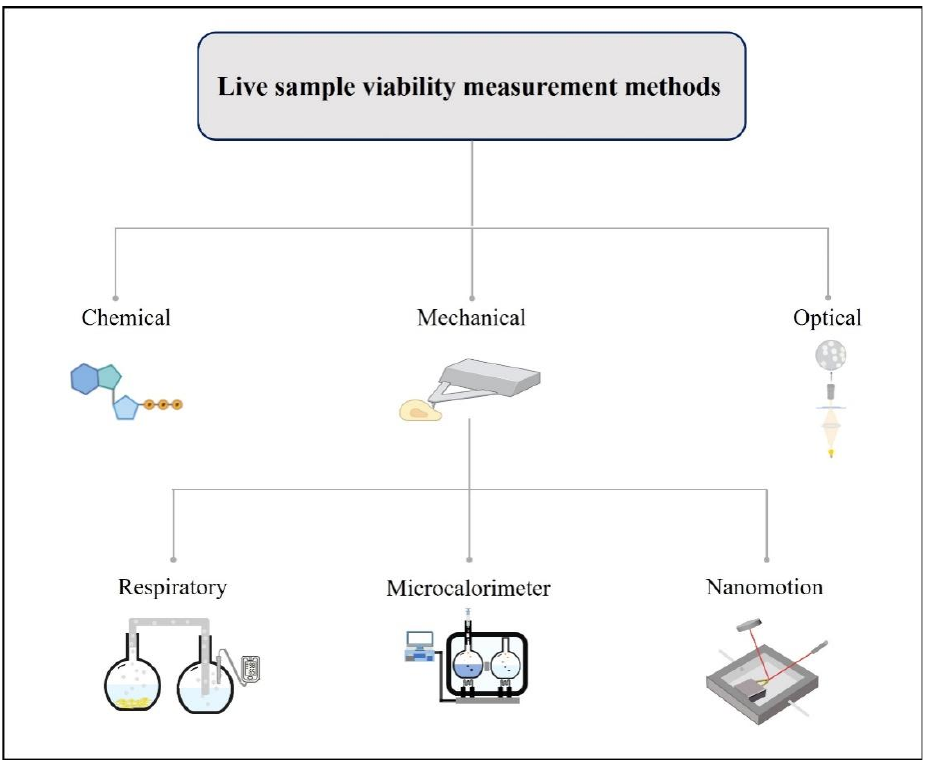
Figure 1. Viability measurement methods are classified according to the equipment or materials used in the measurement process, such as chemical viability assays and optical or mechanical methods.